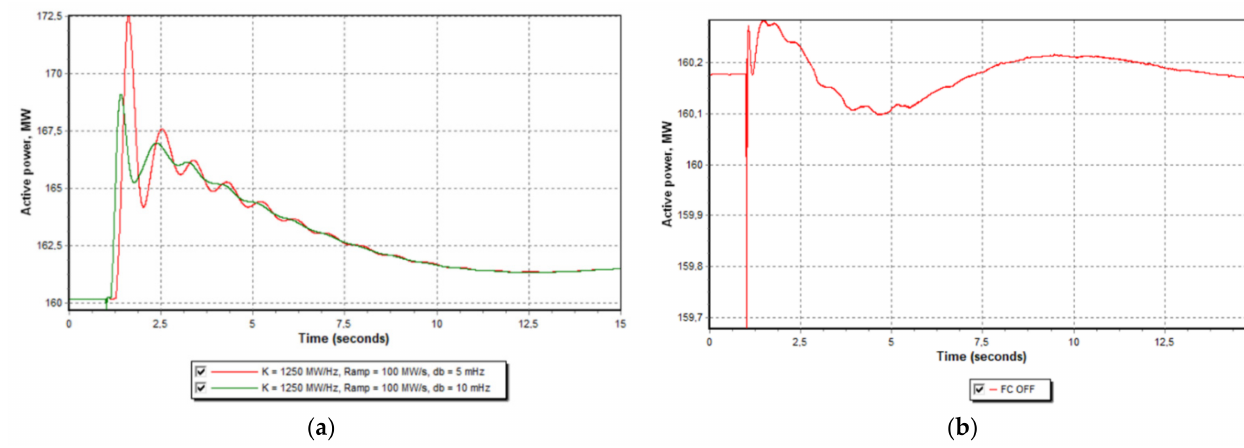
Figure 14. ( a ) Active power response of the HVDC BtB converter. ( b ) Reaction of the HVDC BtB converter when FC is